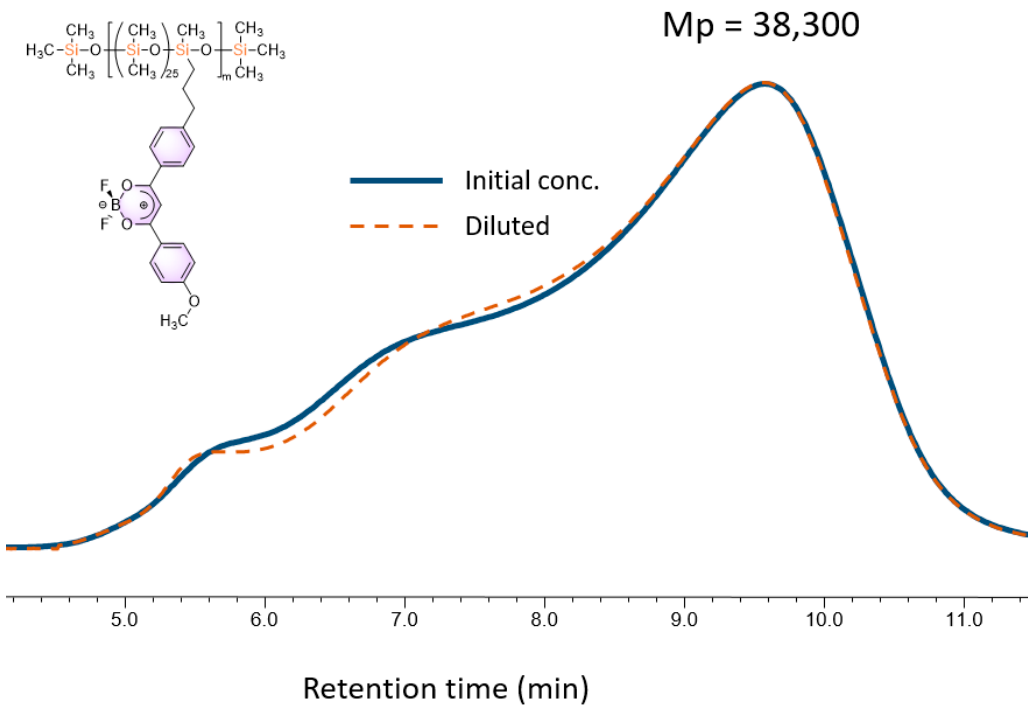
Figure 2. GPC curves of polymer 3 a obtained in THF using column Phenogel 10 5 Å.